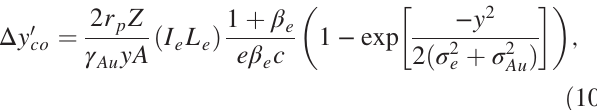
for the Blue horizontal and x;y